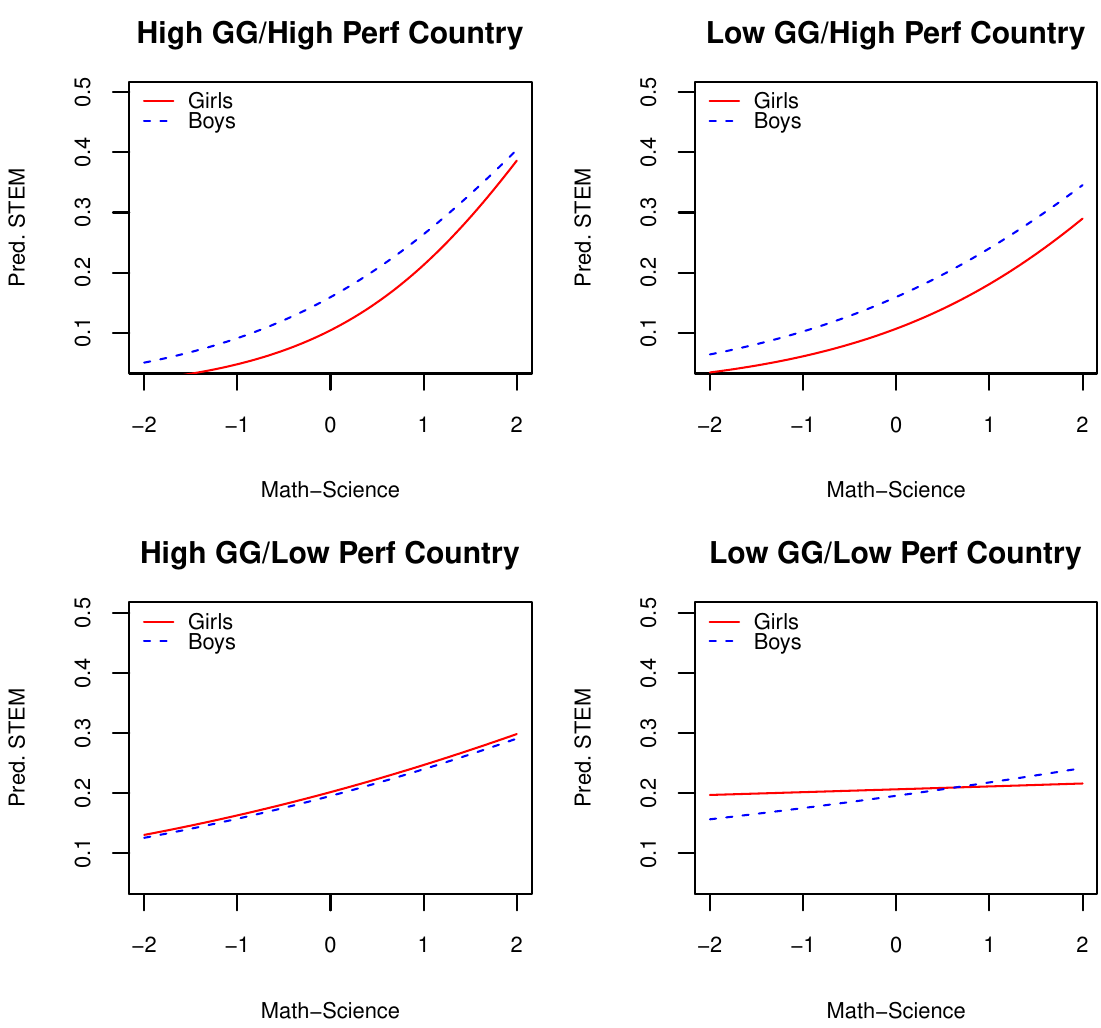
Figure 6: Predictive margins for boys and girls on the STEM orientation returns to math-science performance by the national gender gap in the self-assessment